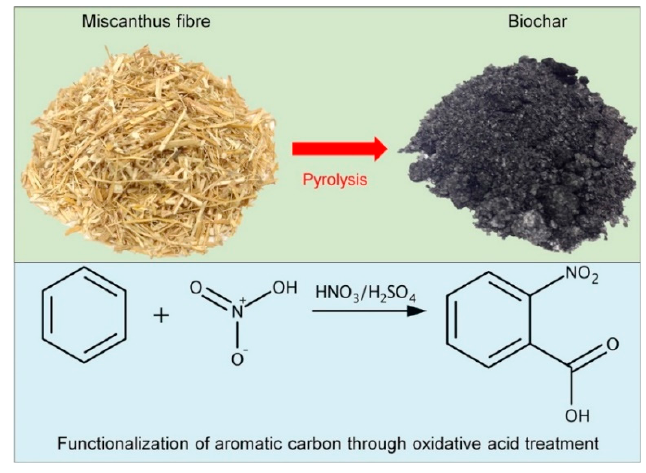
Figure 1. Fabrication of biochar [37]. Table 2. Mechanical properties of hybrid biocomposite